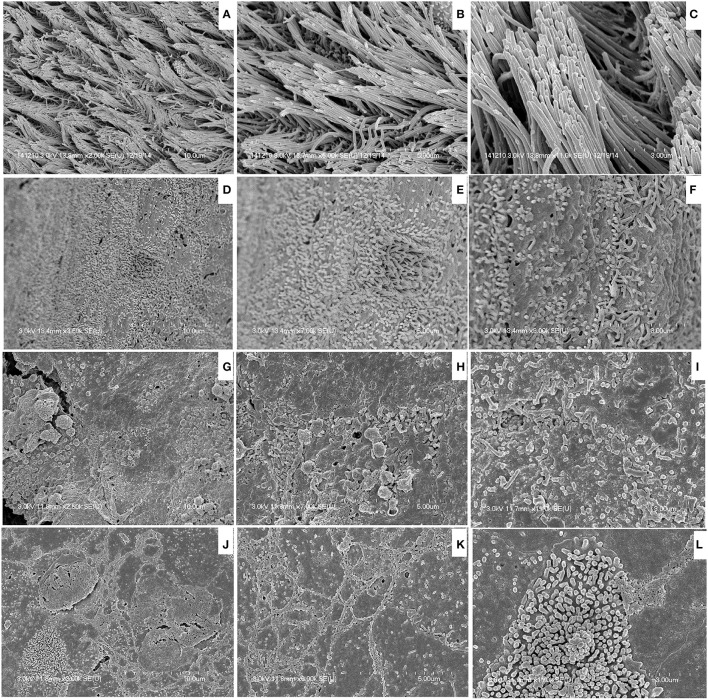
Scanning electron microscope (SEM) images of bullae inoculated with methicillin-resistant Staphylococcus aureus (MRSA) and Pseudomonas aeruginosa (PA) as a single or multi-species inoculum. (A–C) Representative SEM images of no procedure control. (D–F) Representative SEM images of rat bullae inoculated with SA only. (G–I) Representative SEM images of rat bullae inoculated with PA only. (J–L) Representative SEM images of rat bullae inoculated with a mixed culture of MRSA and PA.